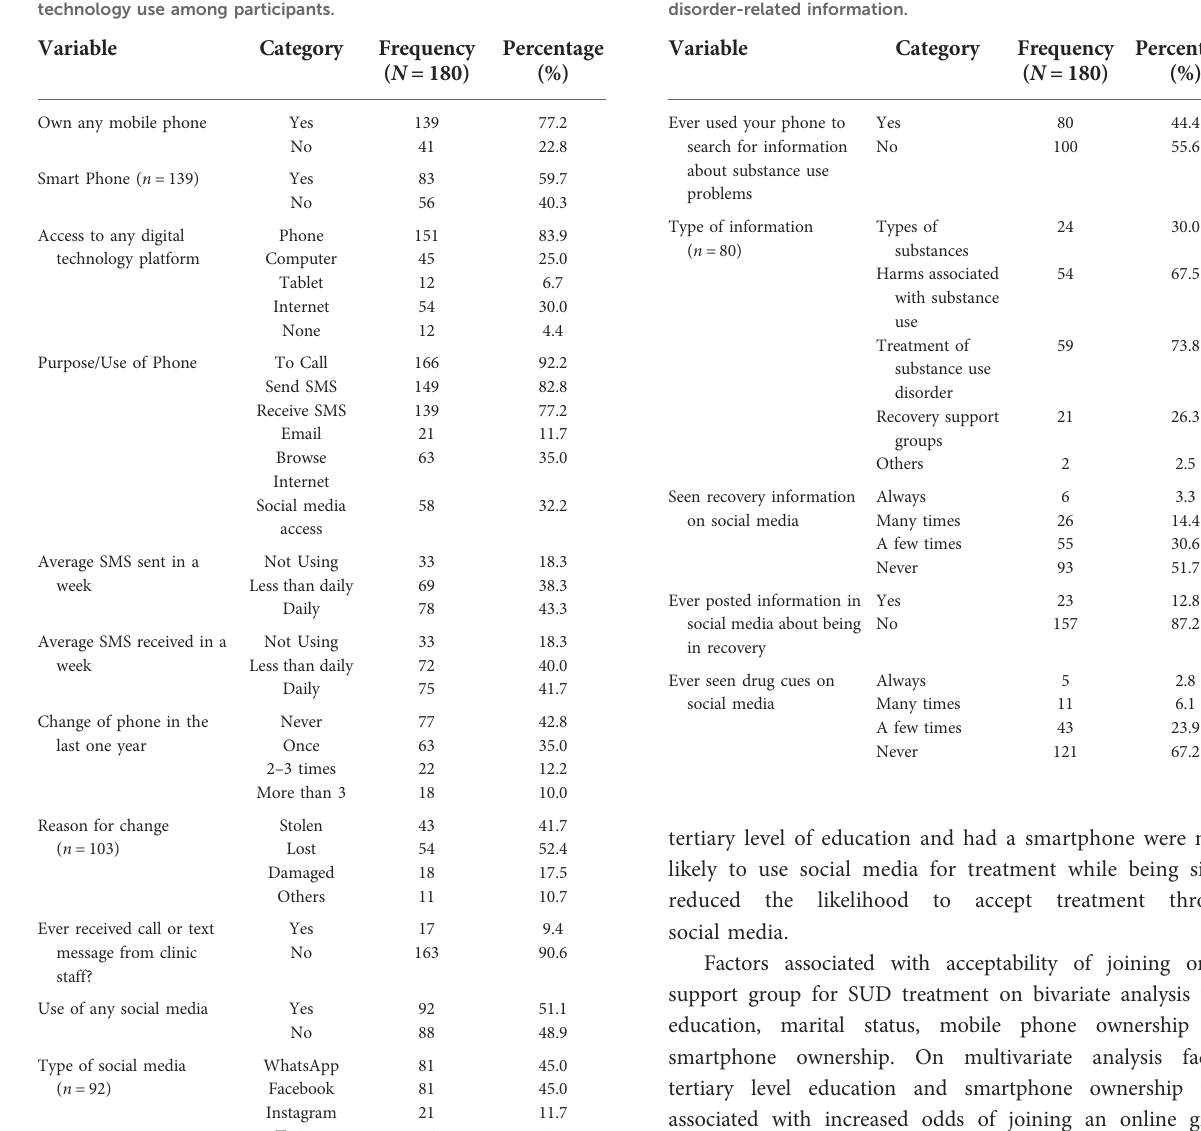
TABLE 3 Summary of social media use to seek substance use disorder-related information.